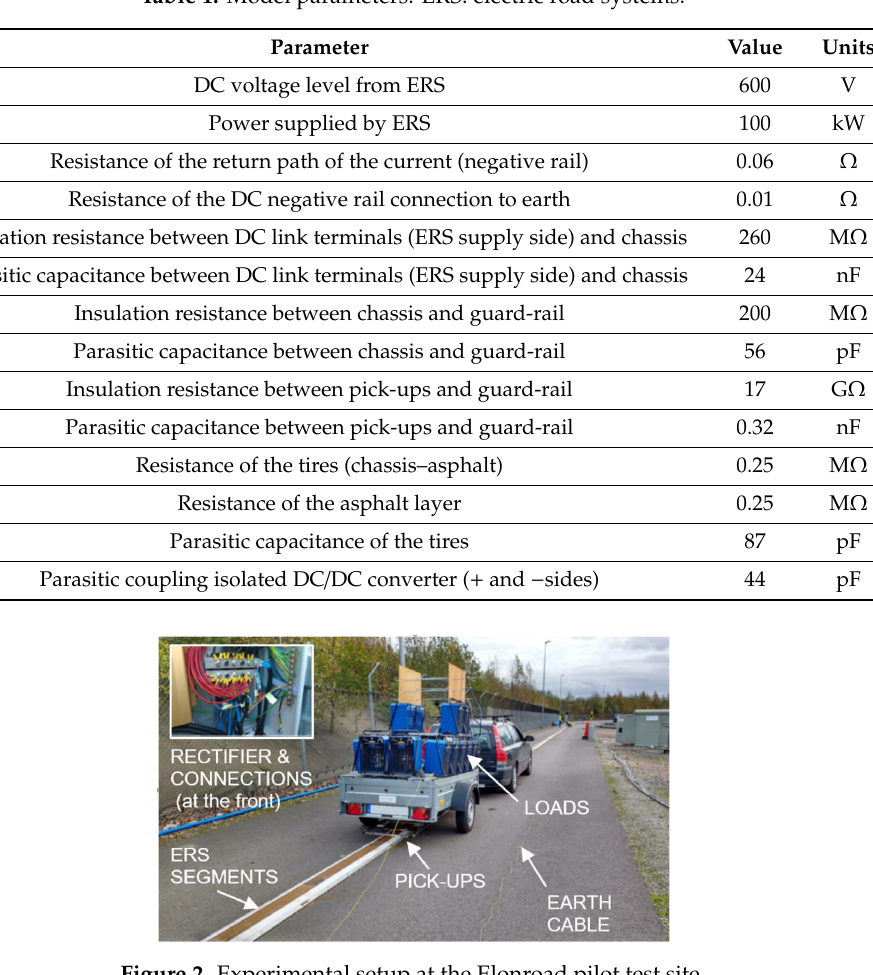
Figure 2. Experimental setup at the Elonroad pilot test site.